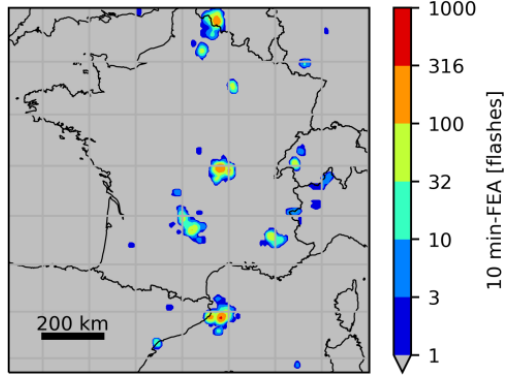
Figure 1. Synthetic MTG-LI observation generated in the domain of interest (in gray), accumulated over 10min between 20:55 and 21:05UTC on 7 August